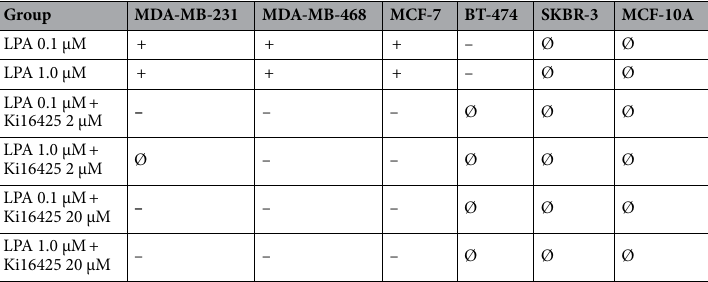
Table 6. Transmigration assay. Effect of lysophosphatidic acid (LPA) 18:1 and the LPA receptor 1, 3 (and 2) inhibitor Ki16425 on transmigration of different human breast (cancer) cell lines. n = 2 replicate experiments. Ø: no effect; +: stimulatory trend; –: inhibitory trend. For LPA 0.1 μM and LPA 1.0 μM stimulation was compared to the control group; for LPA 0.1 μM/LPA 1.0 μM + Ki16425 2/20 μM inhibition was compared to the respective LPA group without